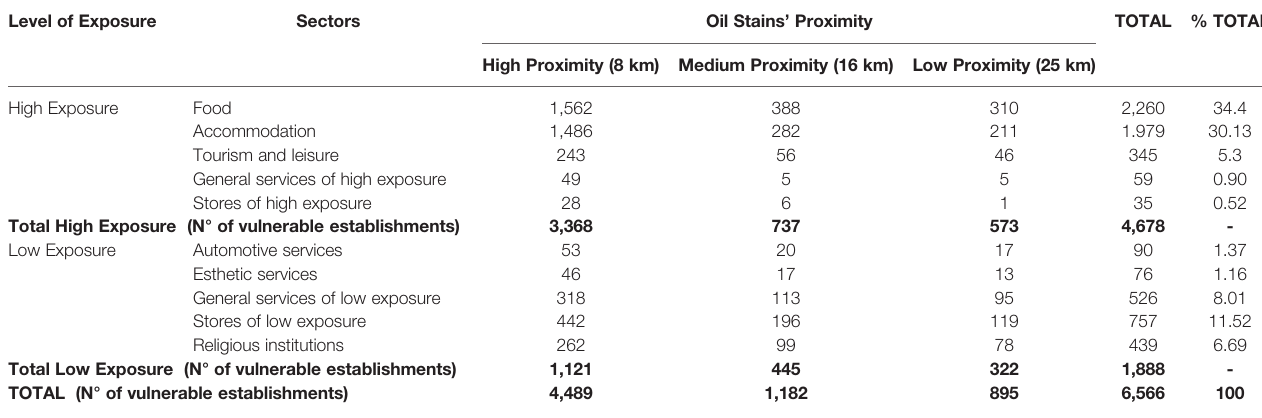
TABLE 3 | Total of institutions categorized by sector and level of exposure of the human communities mapped on boundaries of Marine Protected Areas (MPAs) affected by the oil spill (2019/2020) in the states of Alagoas, Bahia, Pernambuco, and Rio Grande do Norte, located in the Northeast region of Brazil (Southwestern Atlantic). Level of